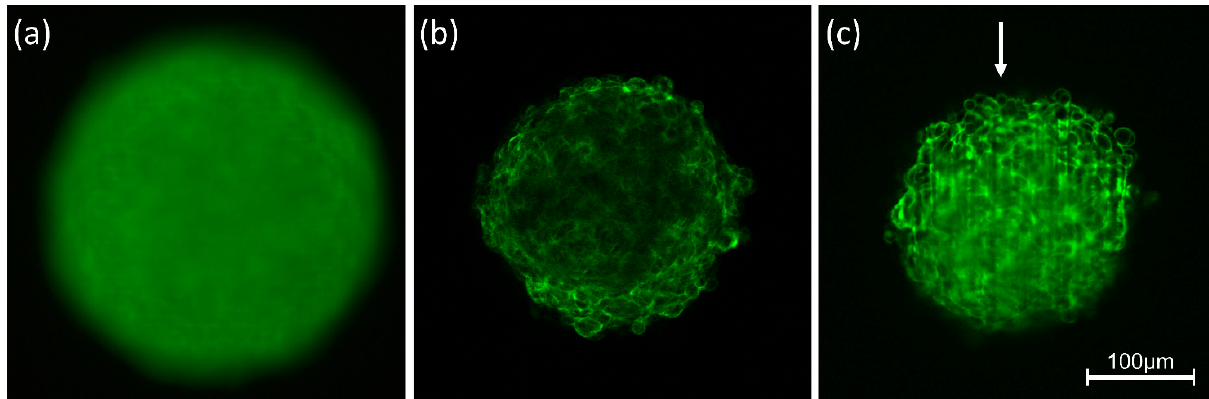
Figure 1. Spheroids of CHO-pAcGFP1-Mem cells recorded by conventional fluorescence microscopy ( a ), CLSM ( b ) and LSFM ( c ). Single planes are selected in ( b , c ) at a depth of 60 µm within the spheroid; arrow indicates direction of light incidence in LSFM (excitation wavelength: 488 nm; fluorescence detected at λ ≥ 505 nm).